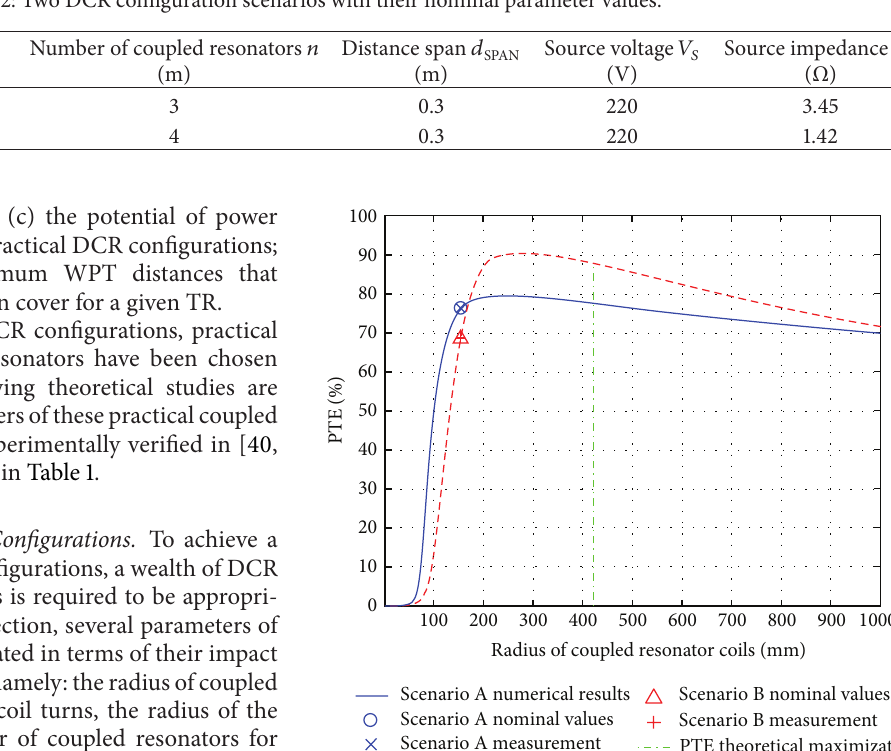
Table 2: Two DCR configuration scenarios with their nominal parameter values.